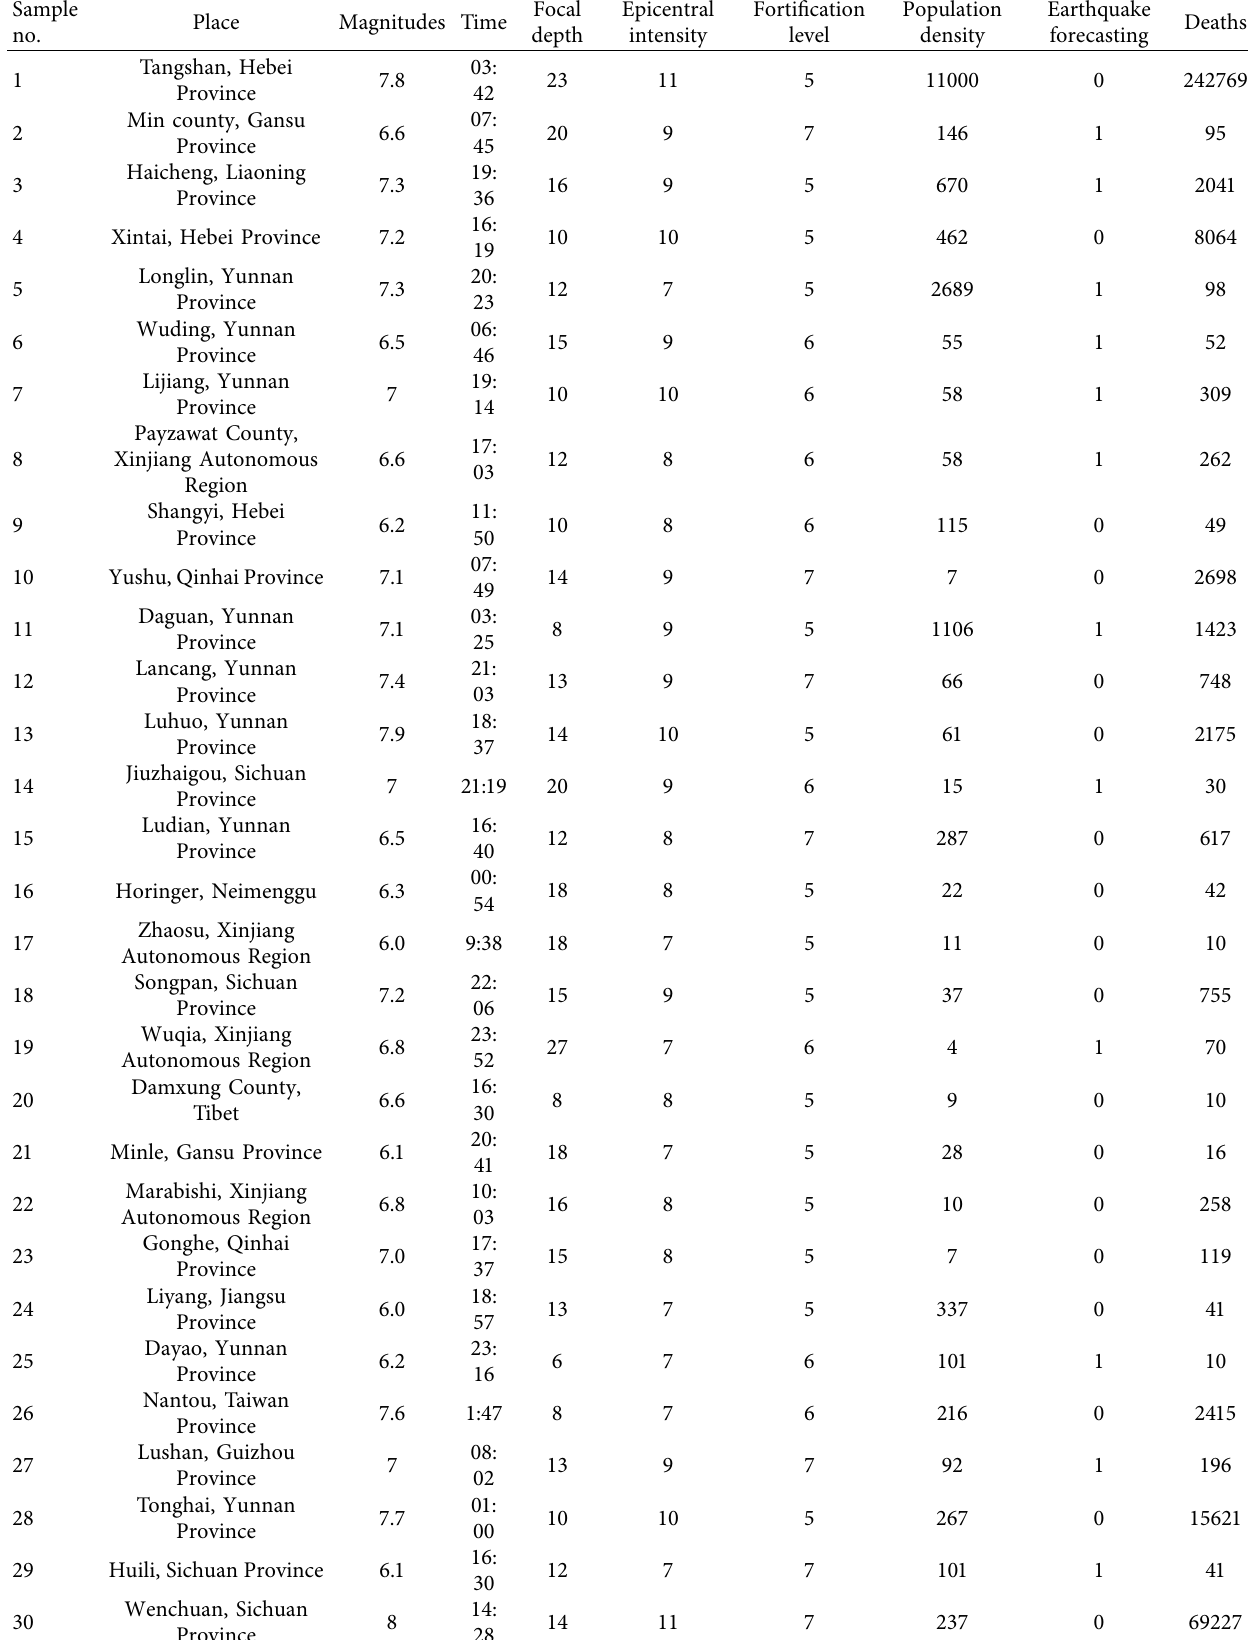
Table 4: Sample data of historical earthquake cases.